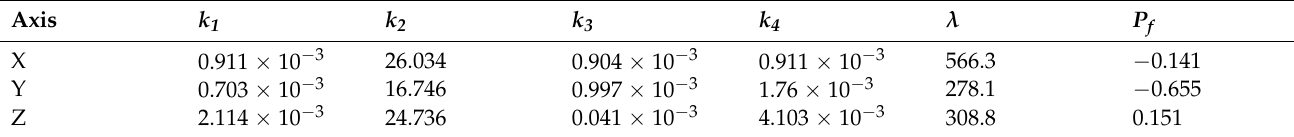
Table 3. Identified parameters of each